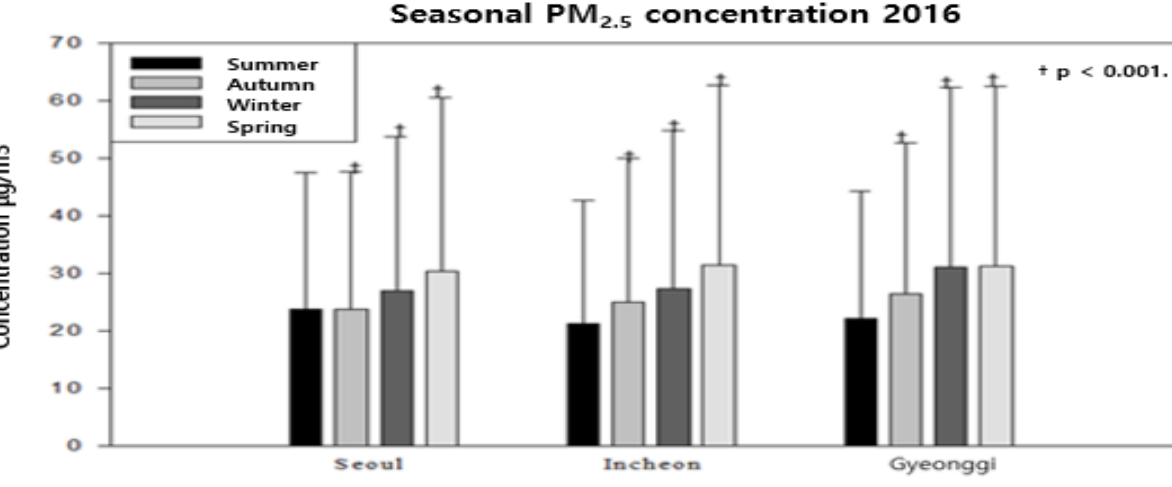
Figure 3. Correlation between the concentration (log-linear) of seasonal fine dust (PM2.5) and the Seoul area (2016).